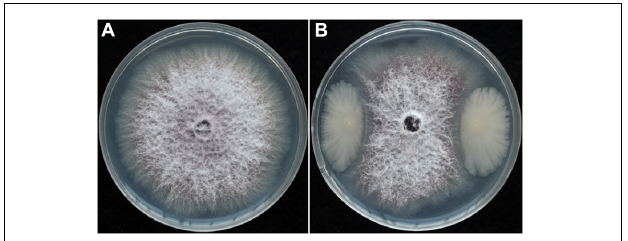
FIGURE 1 | Colony morphology of Foc co-cultivated with or without strain YB-04. (A) Colony morphology of Foc in PDA; (B) inhibition of strain YB-04 on Foc growth.